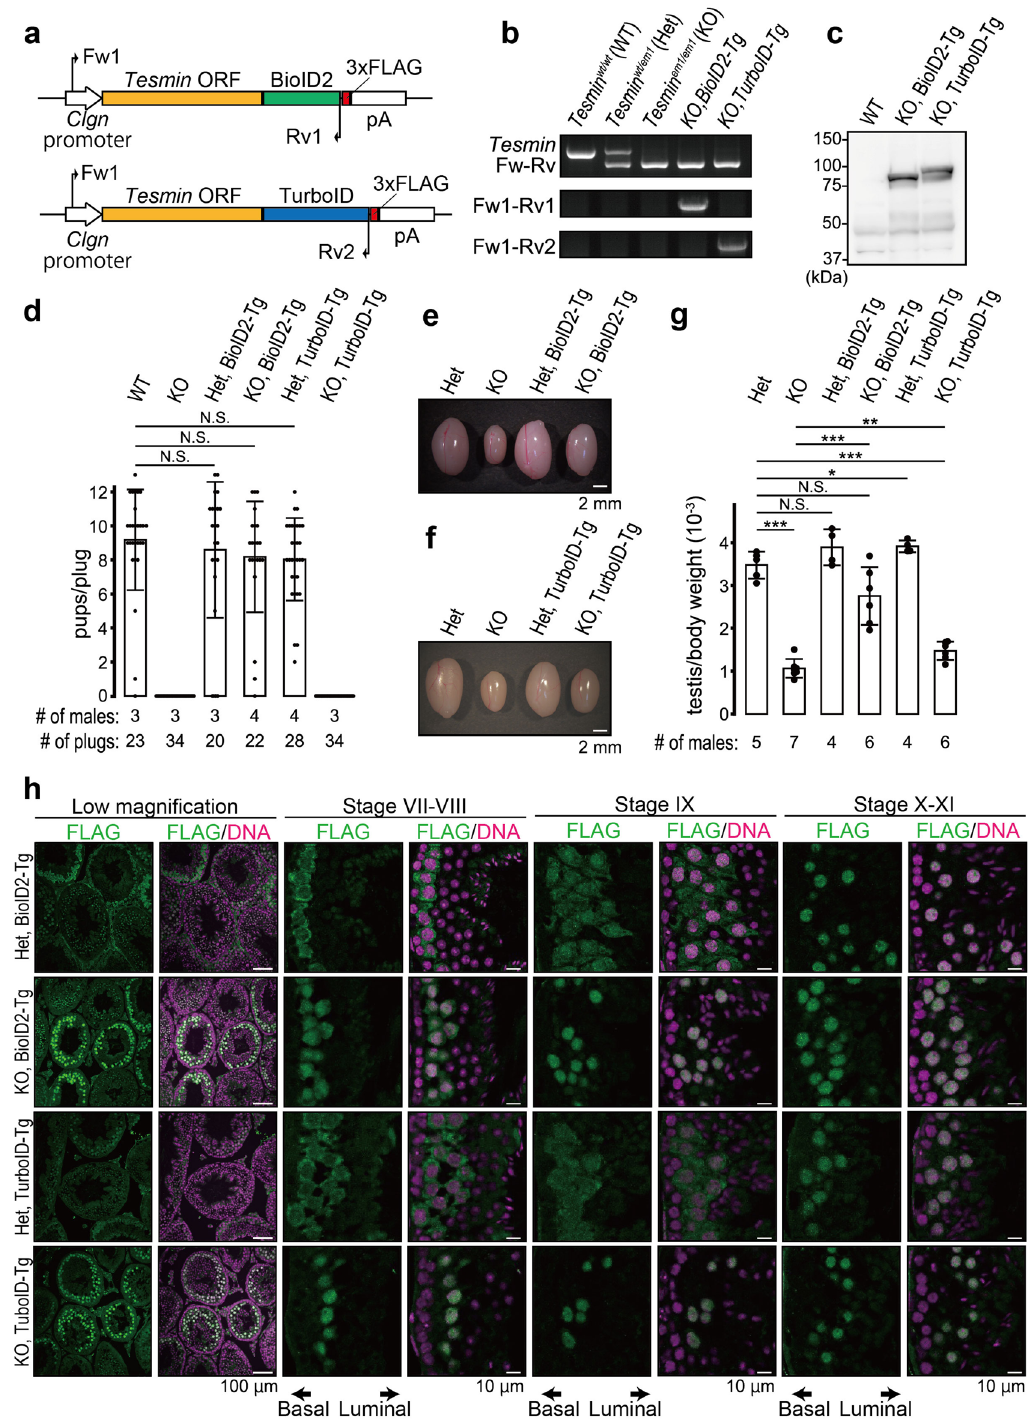
Figure 1. Production of BioID2 and TurboID transgenic mice and fertility analysis. ( a ) Schematic of Tg constructs. White arrows indicate Clgn promoter. Yellow boxes indicate Tesmin ORF (NM_001039657.2). Green and blue boxes indicate BioID2 and TurboID sequences, respectively. Red boxes indicate a 3xFLAG sequence. Black arrows indicate primers for genotyping. ( b ) An example of PCR genotyping with two primer sets shown in ( a ). ( c ) Immunoblot analysis with antibodies against FLAG. ( d ) Schematic of KCTD19 protein structure and antigen position. ( d ) The result of mating tests. Pups/plug: 8.9 ± 1.5 [WT]; 0 [KO]; 8.6 ± 4.0 [Het, BioID2-Tg]; 8.2 ± 3.3 [KO, BioID2-Tg]; 8.0 ± 2.4 [Het, TurboID-Tg]; 0 [KO, TurboID-Tg]. Error bars indicate standard deviations. p-value: 5.5 × 10